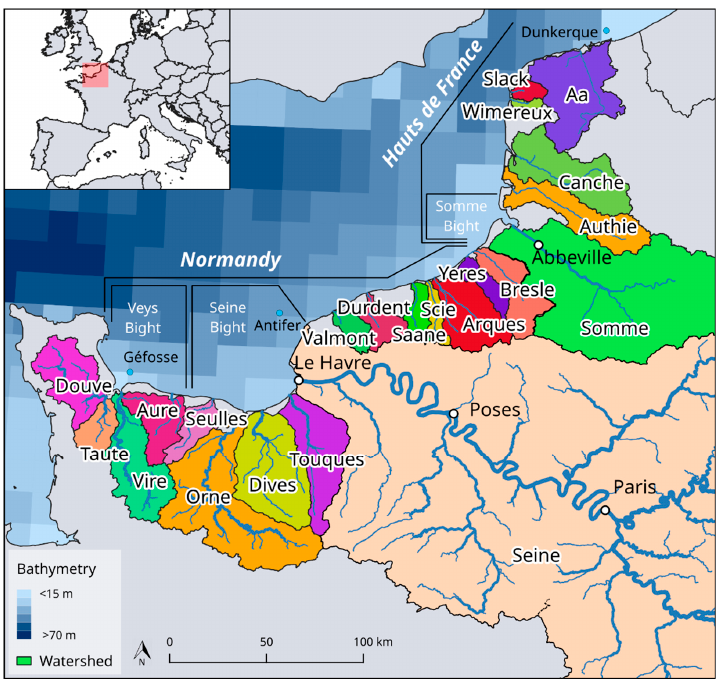
Figure 1. Domain of the study : the river networks adjacent to the Normandy and Hauts-de-France coastlines; and the Seine Bight and the English Channel (16 km × 16 km) where the GRAFS- RIVERSTRAHLER and ECO-MARS3D models were respectively implemented. The names of the watershed (black shaded with white) and the stations (black) used for validation are indicated.